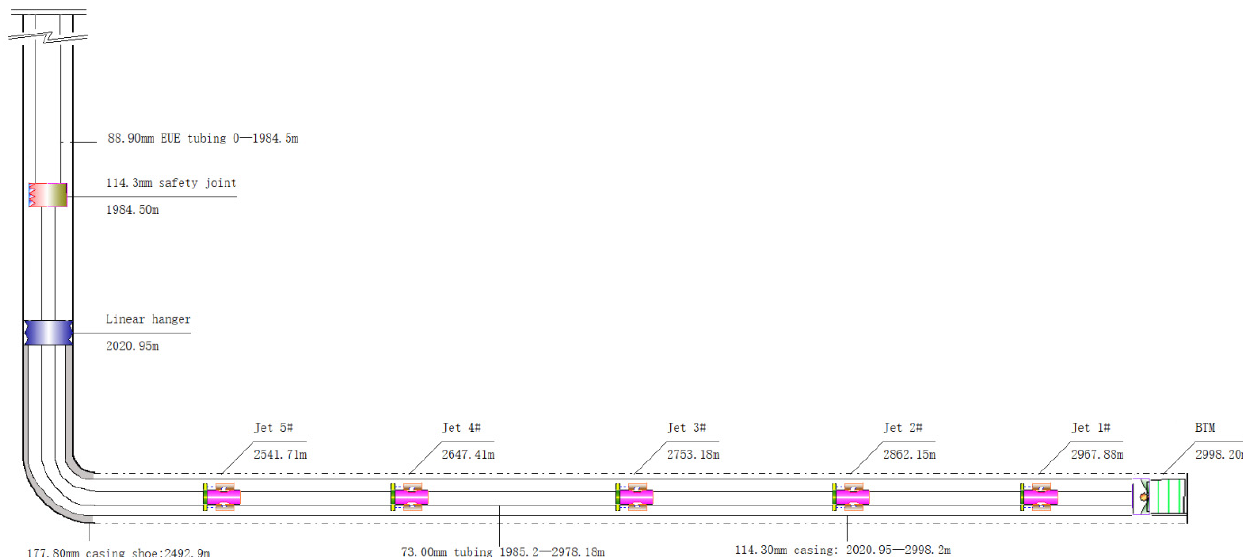
Figure 2. Schematic of fixed-string hydra-jet multistage